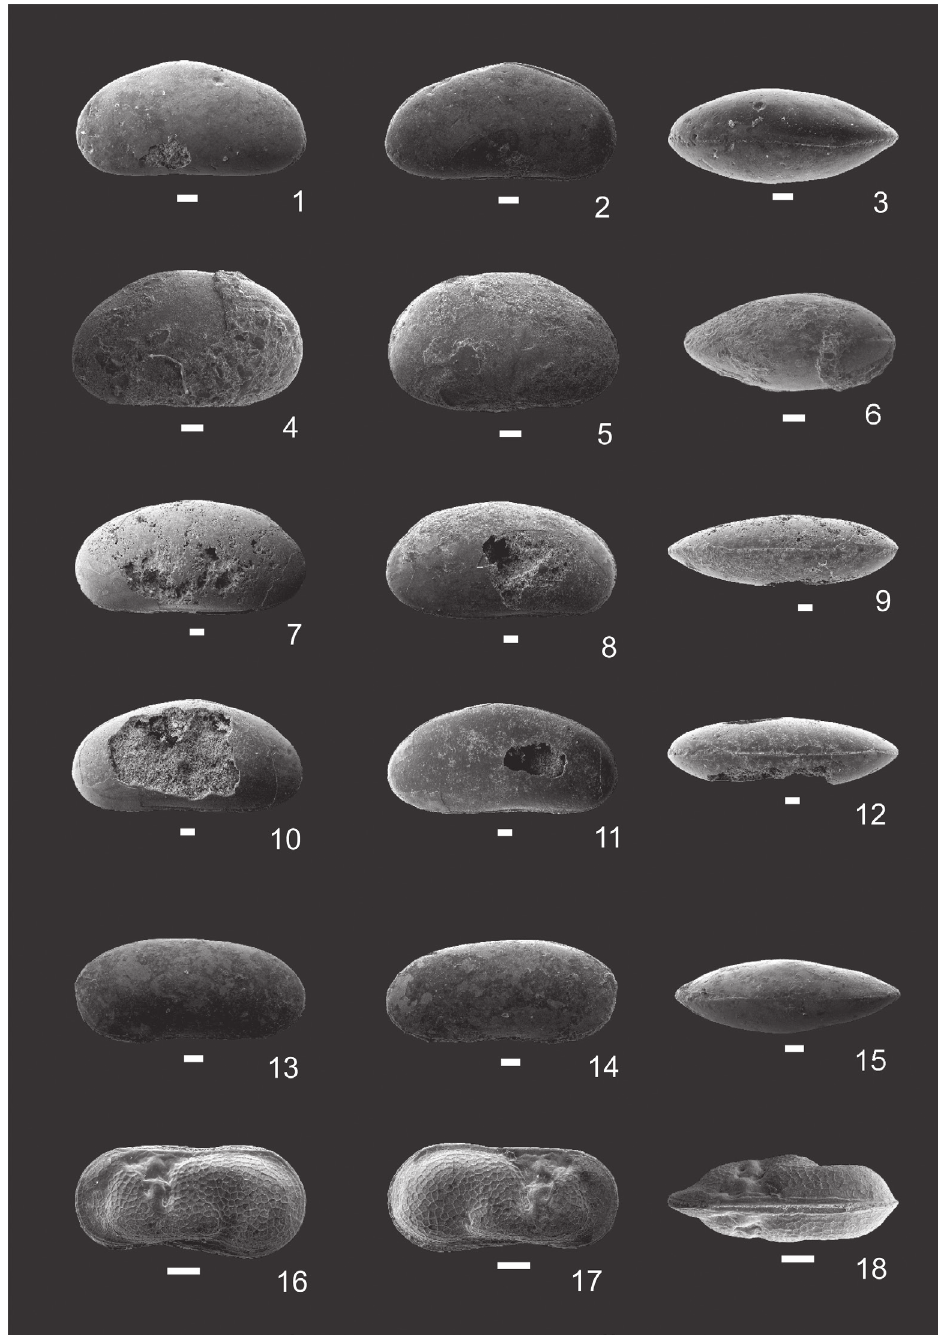
Figure 4 - 1-3 Eucypris sp. 1 (ULVG 11514, C), 1. Left lateral view; 2. Right lateral view; 3. Dorsal view; 4-6 Eucypris sp. 2 (ULVG 11515, C), 4. Left lateral view; 5. Right lateral view; 6. Dorsal view; 7-12 Herpetocypris sp. 1 (ULVG 11517, female C), 7. Left lateral view; 8. Right lateral view; 9. Dorsal view; 10. Left lateral view (ULVG 11516, male C); 11. Right lateral view; 12. Dorsal view; 13-15 Herpetocypris sp. 2 (ULVG 11518, C), 13. Left lateral view; 14. Right lateral view; 15. Dorsal view. 16-18 Limnocythere mandubi sp. nov. (ULVG 11519, C), 16. Left lateral view; 17. Right lateral view; 18. Dorsal view.